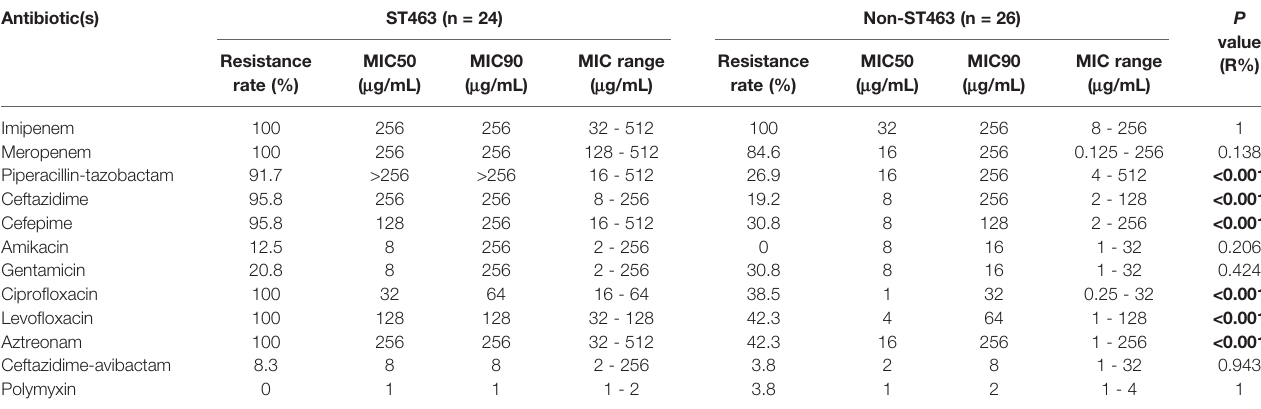
Bolded p-values indicate P ≤